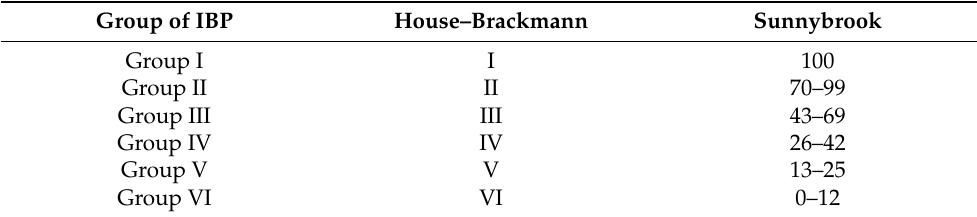
Table 1. Groups of patients with idiopathic Bell’s palsy (IBP) and comparison between House- Brackman (HB) and SunnyBrook (Sb) grading scale values